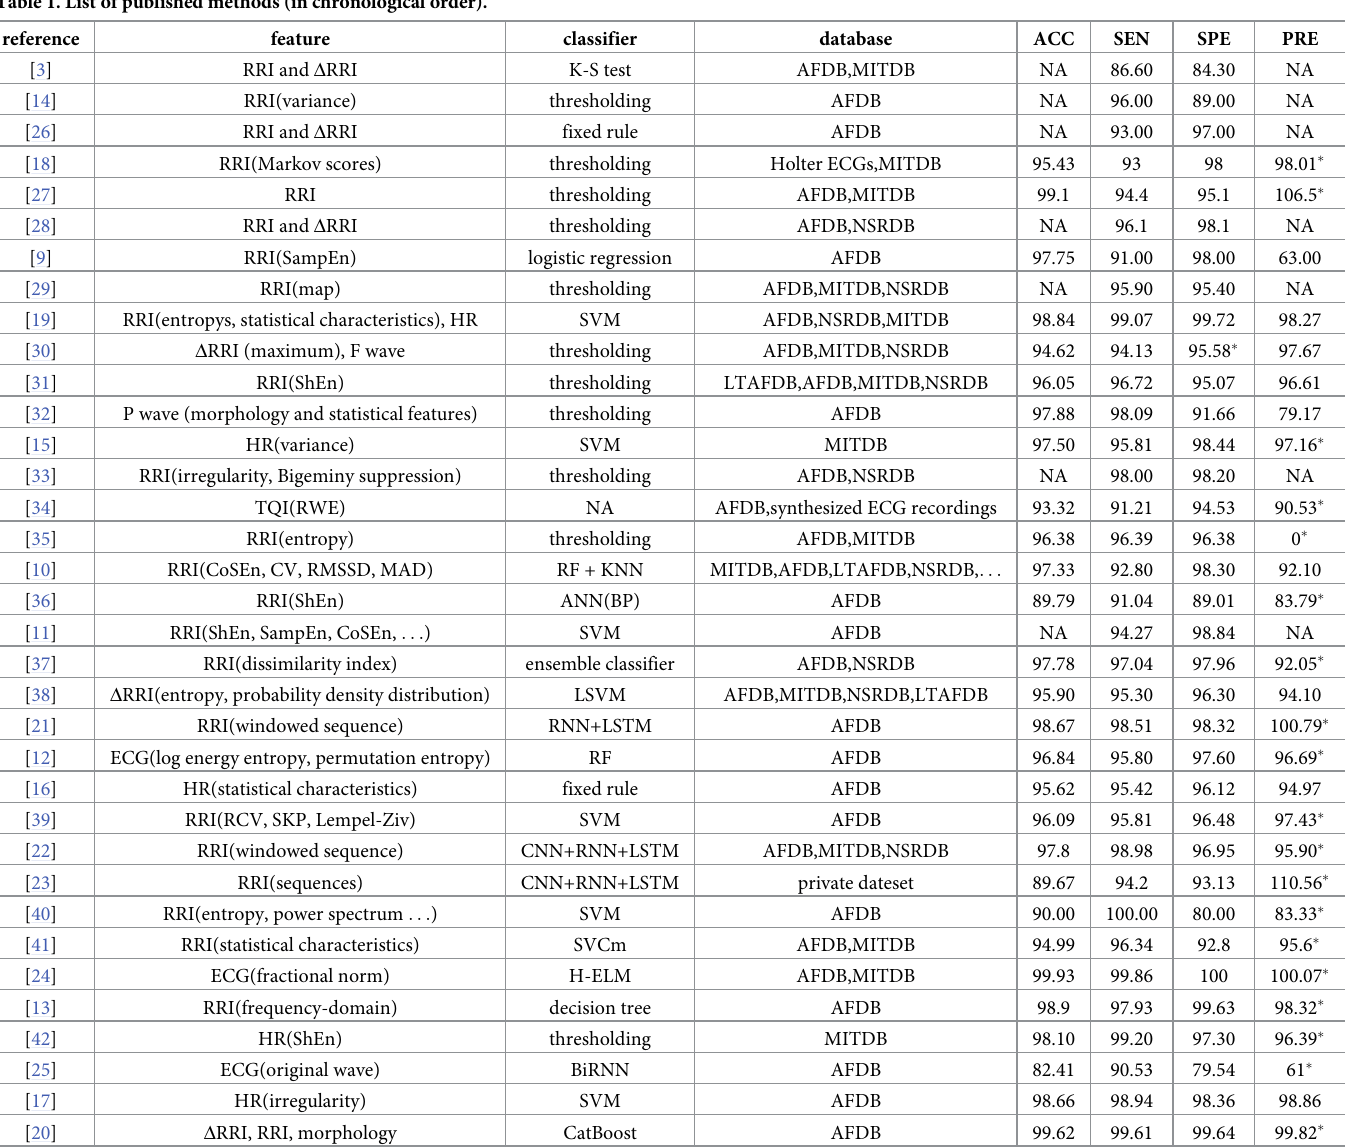
Table 1. List of published methods (in chronological